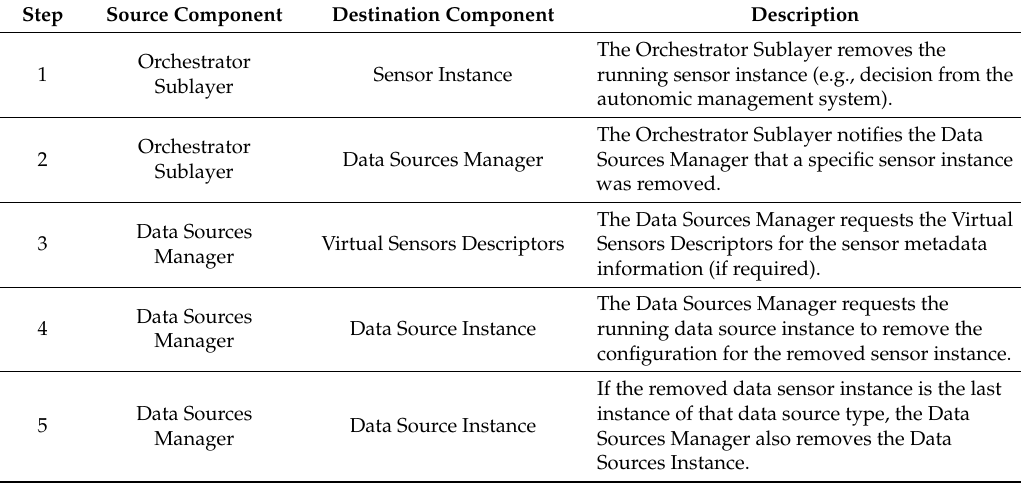
Table 9. Sensor Instance Removal Workflow